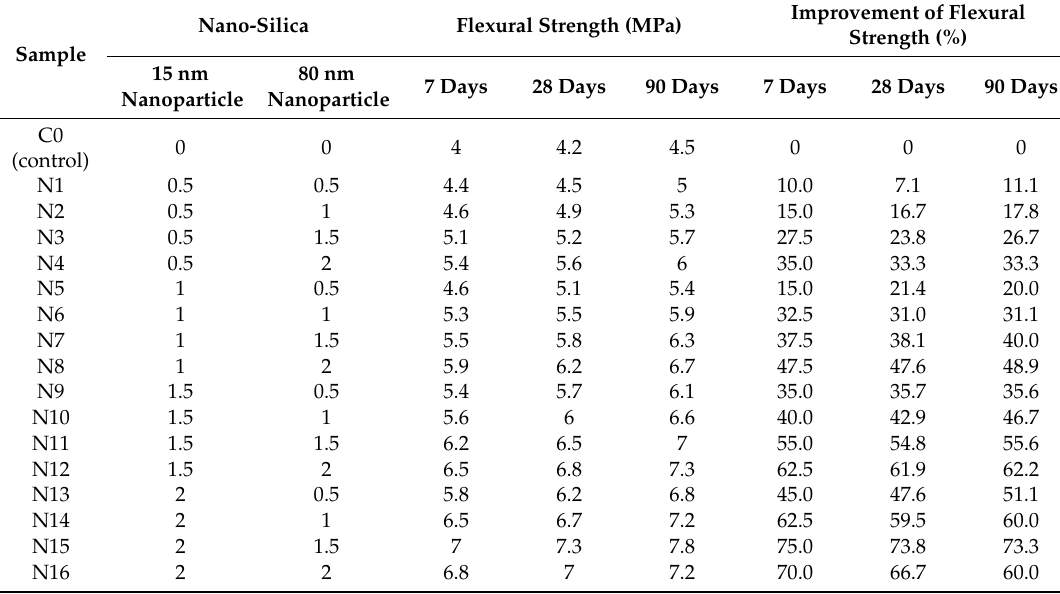
Table 3. Flexural strength of concrete specimens containing several nano-silica contents. Reprinted with permission from [86]. Copyright © 2019, Elsevier